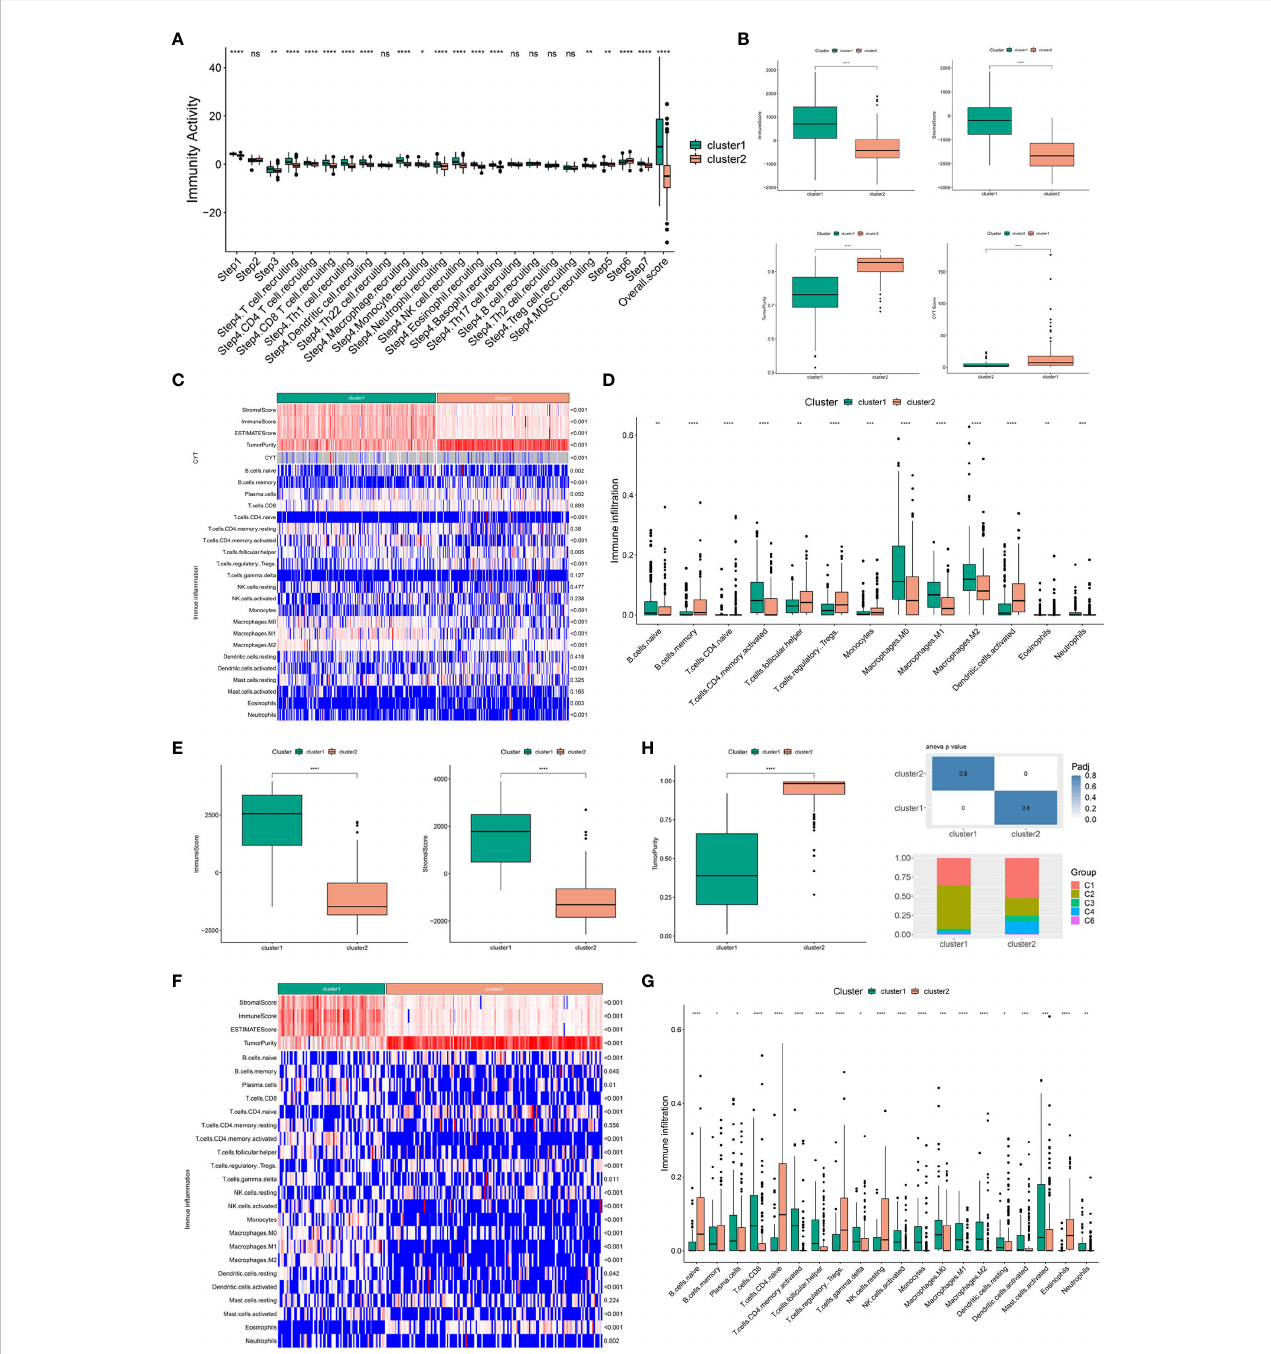
FIGURE 5 Association of immune clusters with immune microenvironment characteristics. (A) Distribution of immune activity scores in IC1 and IC2. (B) Association of immune subtypes with immune scores, stromal scores, tumor purity and CYT in TCGA cohort. Heatmap (C) and bar plot (D) of the relationship between immune clusters and immune cell subpopulations in TCGA cohort. (E) Association of immune subtypes with immune scores, stromal scores and tumor purity in the GSE32894 cohort. Heatmap (F) and bar plot (G) of the relationship between immune clusters and immune cell subpopulations in the GSE32894 cohort. (H) Distribution of individual immune categories in the two immune clusters. *P < 0.05, **P < 0.01, ***P < 0.001, ****P < 0.0001; ns, not signi fi